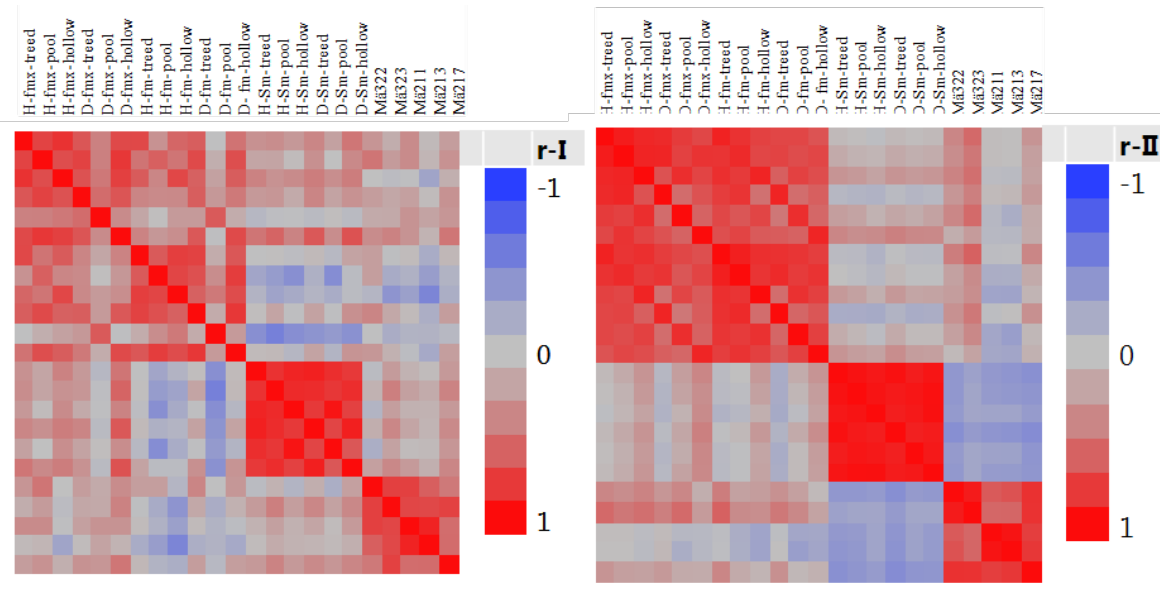
Figure 12. Multiple regressions maps (r-I, r-II) of Männikjärve Bog (Mä) ground-level variables for average winter seasons (Periods I and II). The variables used are: mean (fm) and maximum (fmx) soil frost depths; and mean snow depths (Sm) in depressions (D) and hummocks (H) of treed, ridge-hollow and ridge-pool ecotopes. Abbreviations for the ecotope groundwater levels are: Mä217 = treed, Mä322 & Mä323 = ridge- hollow, and Mä211 & Mä213 = ridge-pool